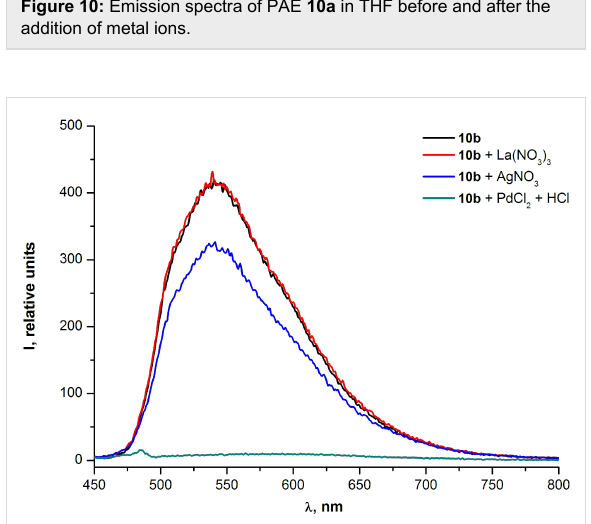
Figure 8: Optical absorption spectra of PAE 10a in THF before and after the addition of metal analytes.